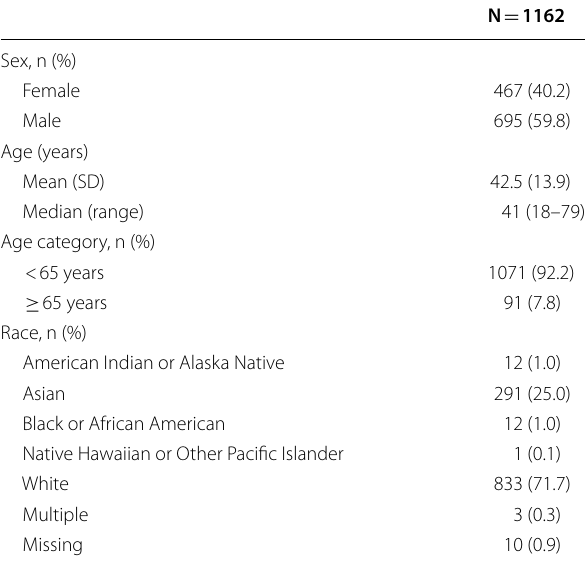
Table 1 Demographics of the study participants in